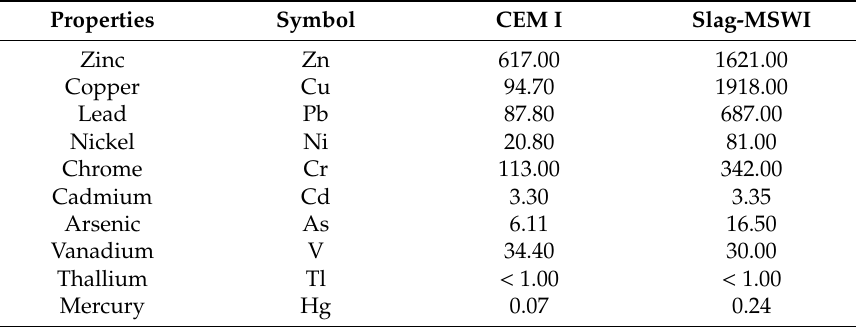
Table 4. Heavy metal concentration, expressed in mg /